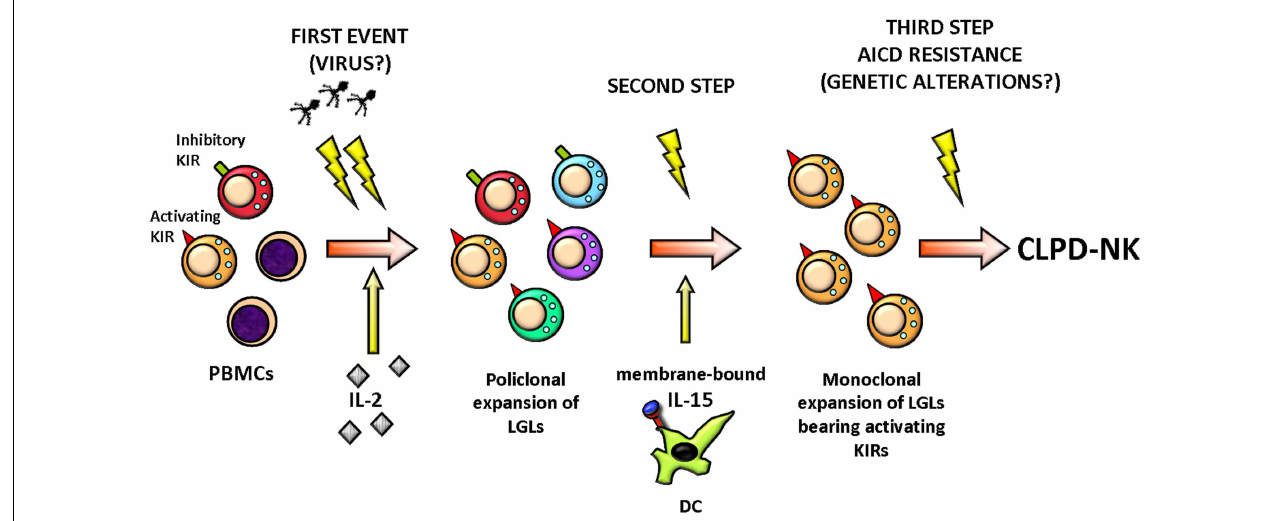
not encounter a resolution for a third event establishing the activation induced cell death (AICD) resistance, probably due to a genetic alteration. All these events result in LGL aberrant outliving and number increase. PBMCs, peripheral blood mononuclear cells; KIR, killer immunoglobulin-like receptor; LGLs, large granular lymphocytes; DC, dendritic cell; AICD, activation induced cell death; CLPD-NK, chronic lymphoproliferative disease of natural killer